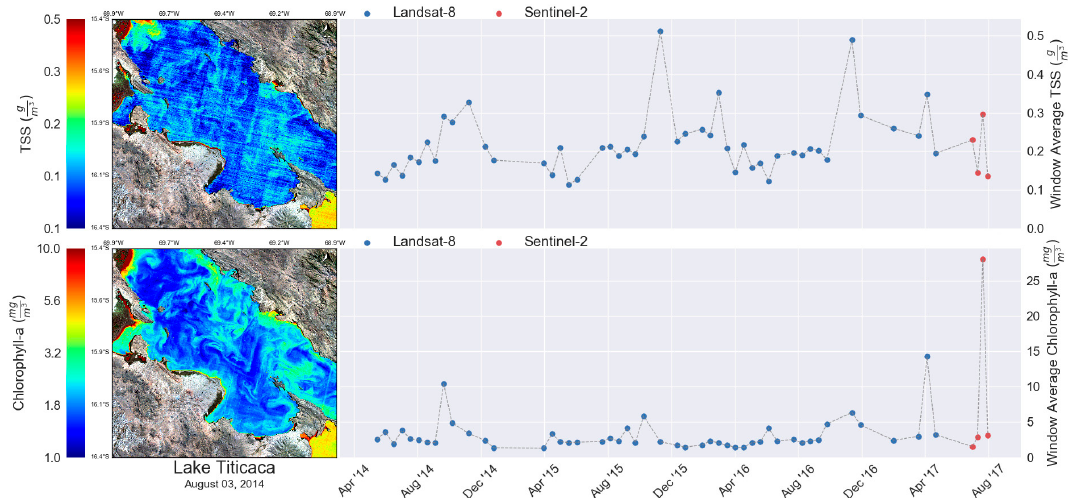
Figure 10. Time-series of lake-wide average TSS (g/m 3 ) and Chl (mg/m 3 ) in Lake Titicaca shown for the 2014–2017 period. Sentinel-2 data capture a major peak in August 2017 where Chl is nearly 25 times higher than normal concentrations.